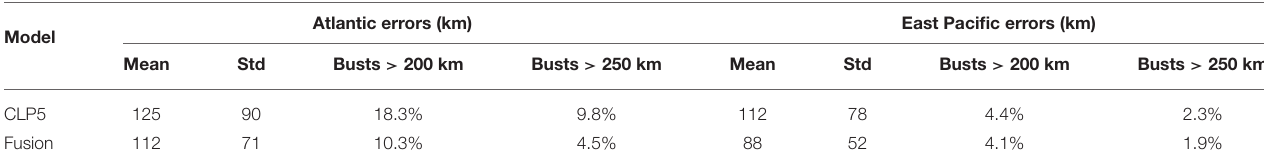
Busts correspond to the ratio of track errors exceeding 200 km (and 250 km).